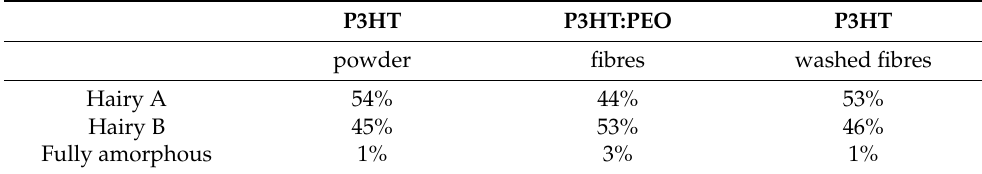
Table 4. Relative amount of the hairy A, hairy B, and fully amorphous phases for the P3HT fibres under investigation. The data are obtained from the intensity ratios of the three band components resulting from the deconvolution of the ECC Raman band. Values obtained for the P3HT powder are reported for sake of comparison. P3HT P3HT:PEO P3HT powder fibres washed fibres Hairy A 54% 44% 53% Hairy B 45% 53% 46% Fully amorphous 1% 3%